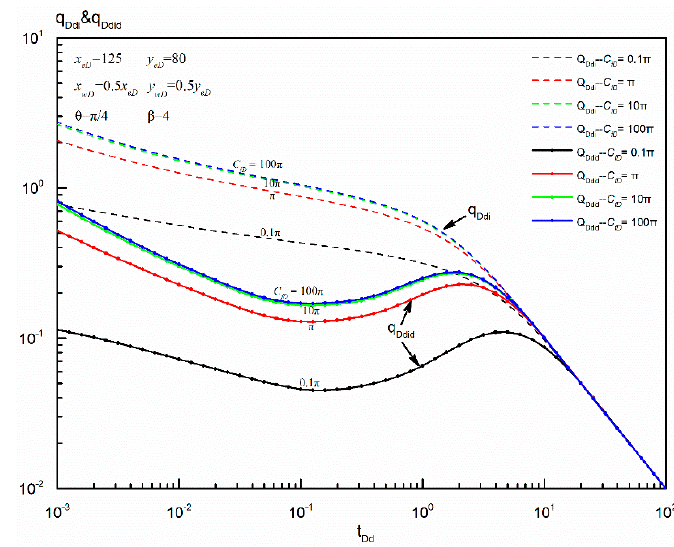
Figure 15. Blasingame format curves for a fractured well in an anisotropic rectangular reservoir at different values of fracture conductivity. Energies 2019 , 12 , x FOR PEER REVIEW 20 of 30